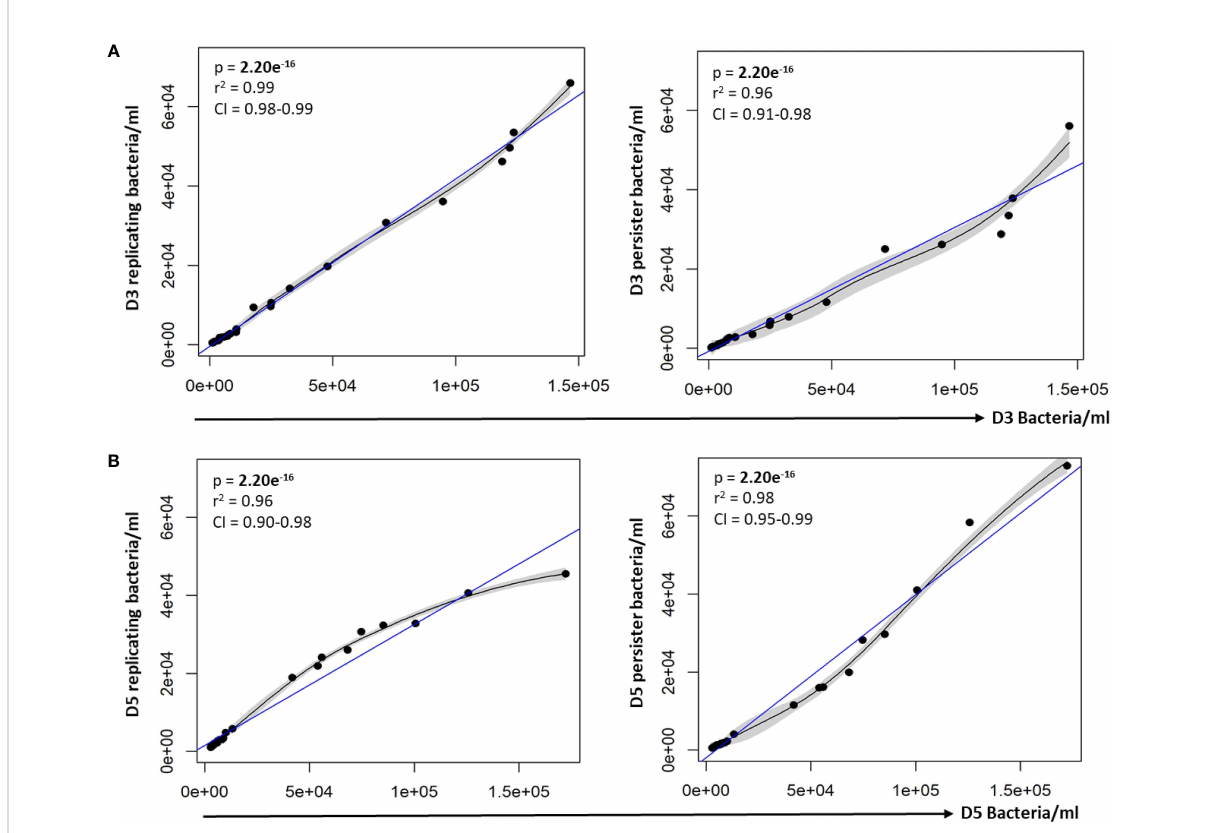
FIGURE 3 Persister numbers correlated with respective intracellular bacterial numbers. A strong correlation between the infection burden observed at (A) day 3 and (B) day 5 in relation to the respective persister numbers was observed on the scatter plot. Data was assessed using the Pearson ’ s product-moment correlation (linear) and is representative of data independently conducted in 7 biological experiments, including technical triplicates. Signi fi cant p-values (p < 0.05) are shown in bold. The blue line represents the regression line for the correlation analyses (Pearson), while the black line and associated shaded area represents the local non-linear regression and 95% con fi dence interval. r 2 , Pearson ’ s correlation coef fi cient squared; CI, 95% con fi dence